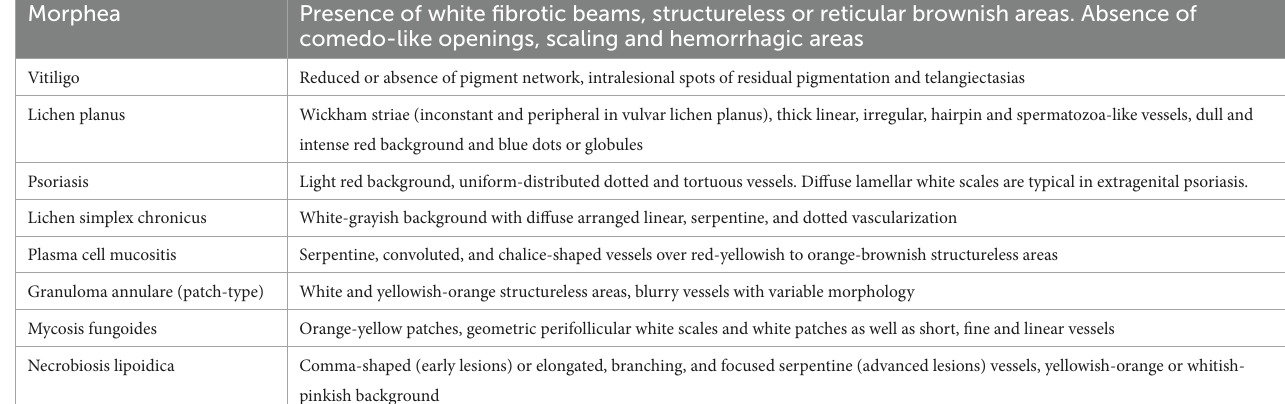
TABLE 5 Summary of dermoscopy differential diagnoses of genital and extragenital lichen sclerosus (140–145). Morphea